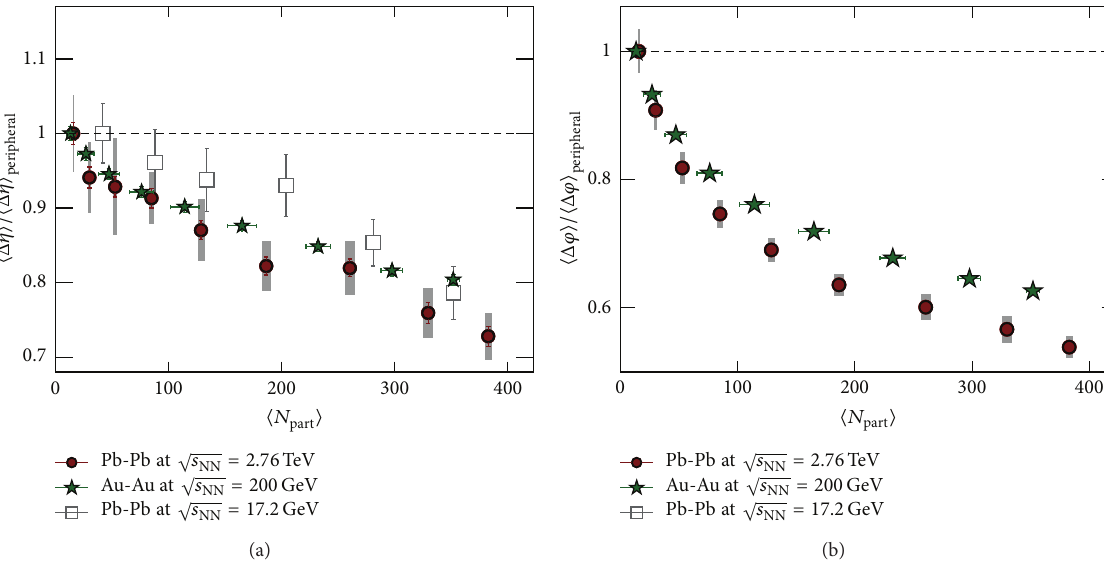
Figure 11: The centrality dependence of the relative decrease of BF width in relative pseudorapidity (a) and relative azimuthal angle (b). The ALICE results are compared with the results for the highest SPS [26, 27] and RHIC [35] energies. The figure is taken from [37].